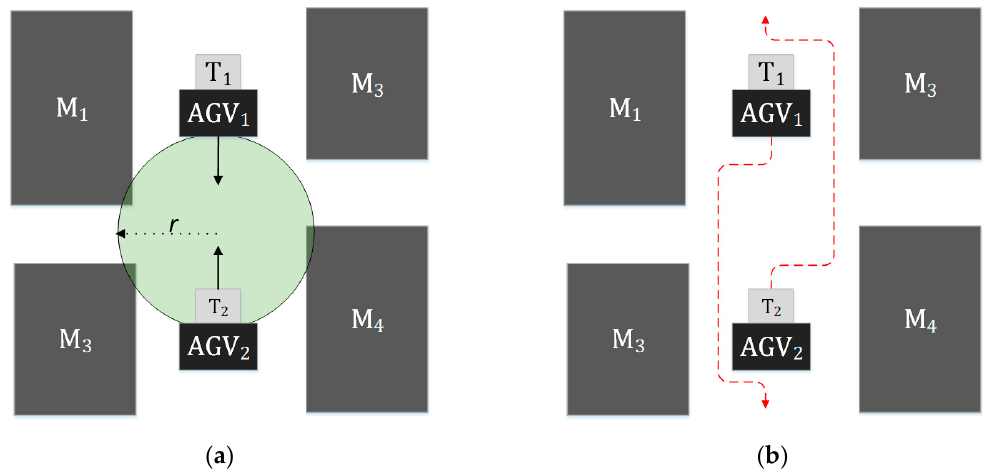
Figure 11. Collision avoidance for Automated Guided Vehicle (AGV) 1 and AGV 2 moving towards each other in the same direction by the cloud system ( a ) Detecting AGVs entering the same radius, ( b ) Creating a local path and re-entering the old path when it leaves the circle.